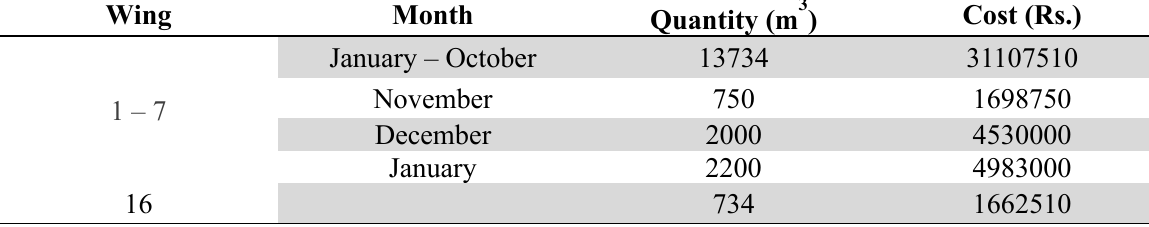
Quantity of excavated hard rock and cost incurred